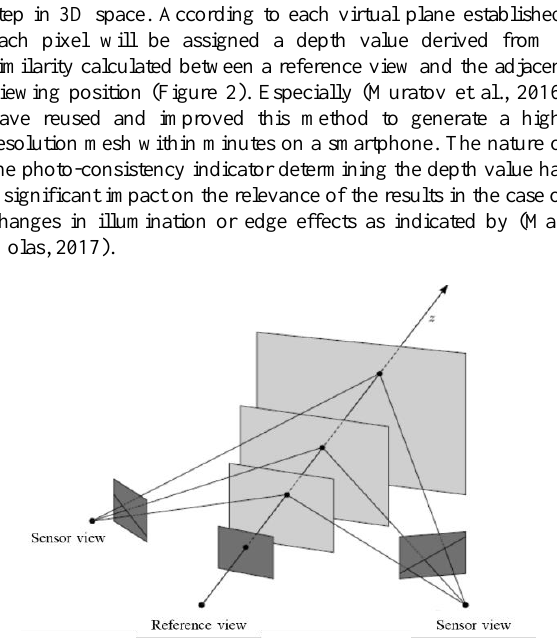
Figure 2. Planesweep method